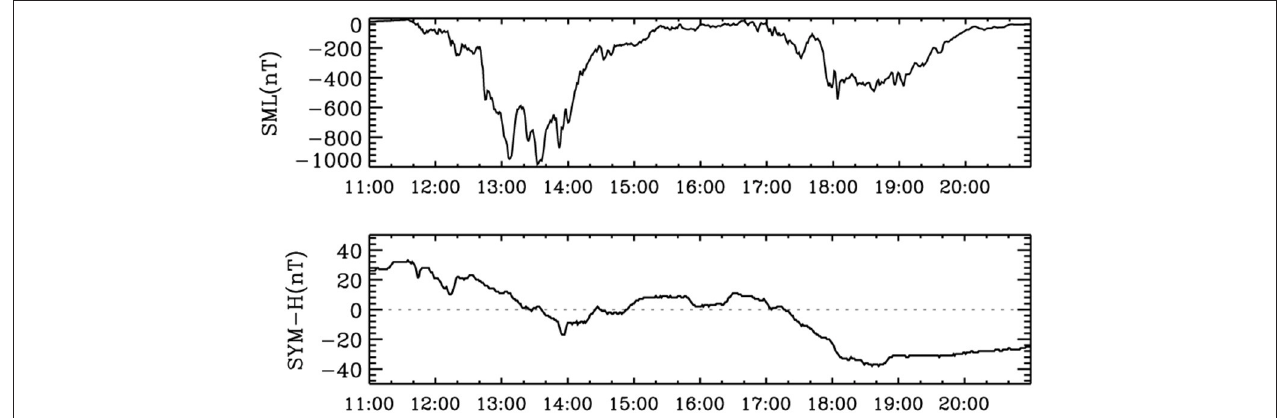
FIGURE 1 | SML index and SYM-H index of the 8 March 2008